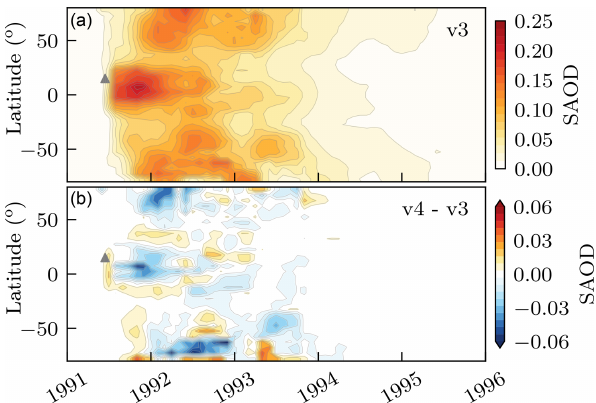
Figure 1. Panel (a) shows aerosol optical depth in the stratosphere (SAOD) at 550nm from the v3 dataset. Panel (b) shows the absolute difference between the versions, computed as v4 − v3, during this same time period. The triangle marks the Pinatubo eruption at 14 ◦ N on 15 June